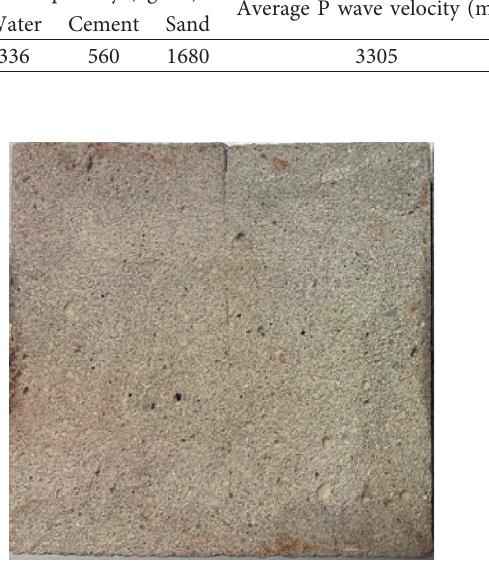
Figure 12: Longitudinal section diagram of the specimen A7.